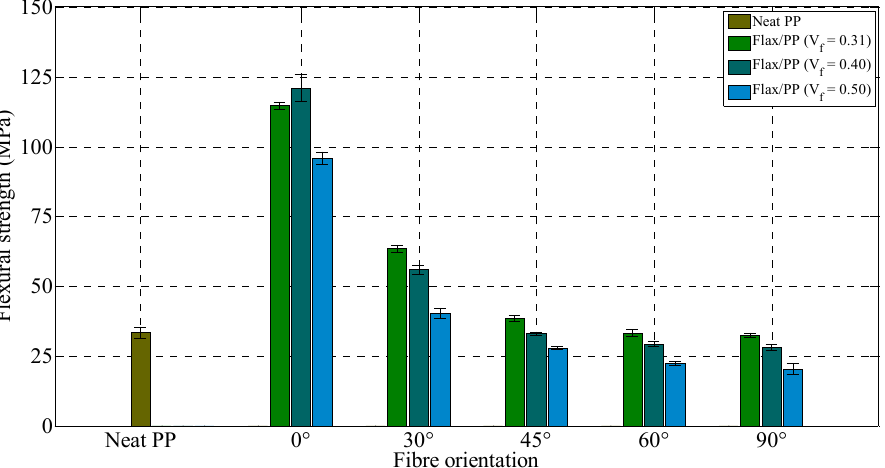
Figure 22. Flexural strength for neat PP and flax/PP samples of different fibre volume fractions and orientations.